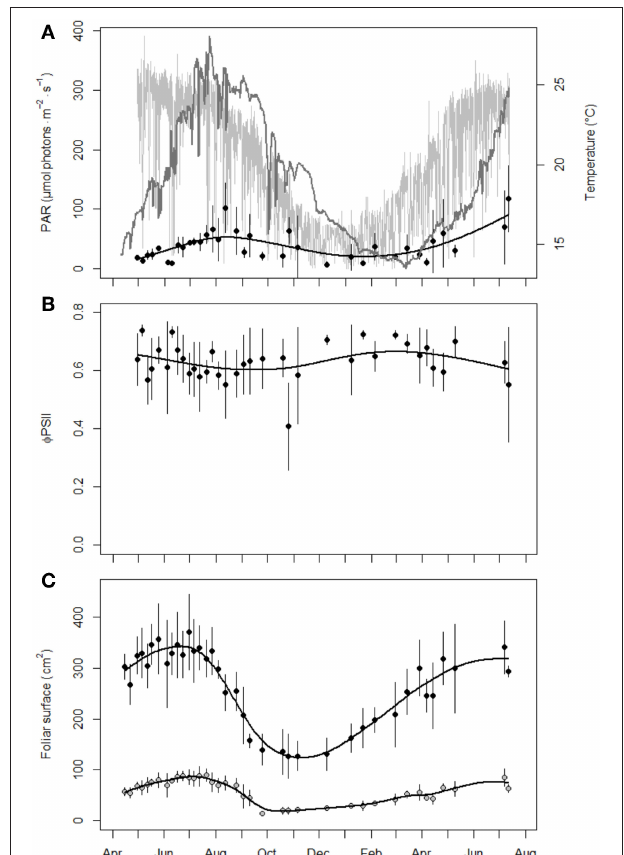
FIGURE 1 | Evolution of environmental and seagrass biological parameters in P. oceanica meadow at 10m depth over time. (A) Temperature ( ◦ C, solid dark gray line) and photosynthetically active radiation (PAR, µ mol photons.m − 2 .s − 1 ) recorded above the meadow canopy (solid light gray line) or within the meadow canopy (dots; mean ± sd, n = 6). (B) Effective quantum yield of photosystem II ( 8 PSII) of P. oceanica third leaf (mean ± sd, n = 6). (C) P. oceanica shoot (black dots) and third leaf (gray dots) foliar surfaces (cm 2 ; mean ± sd, n = 6 except February 29, 2016, n = 5). The solid black lines on graphs (A–C) are predictions from cross-validated smoothing cubic spline analyses on within meadow PAR, 8 PSII and foliar surfaces,